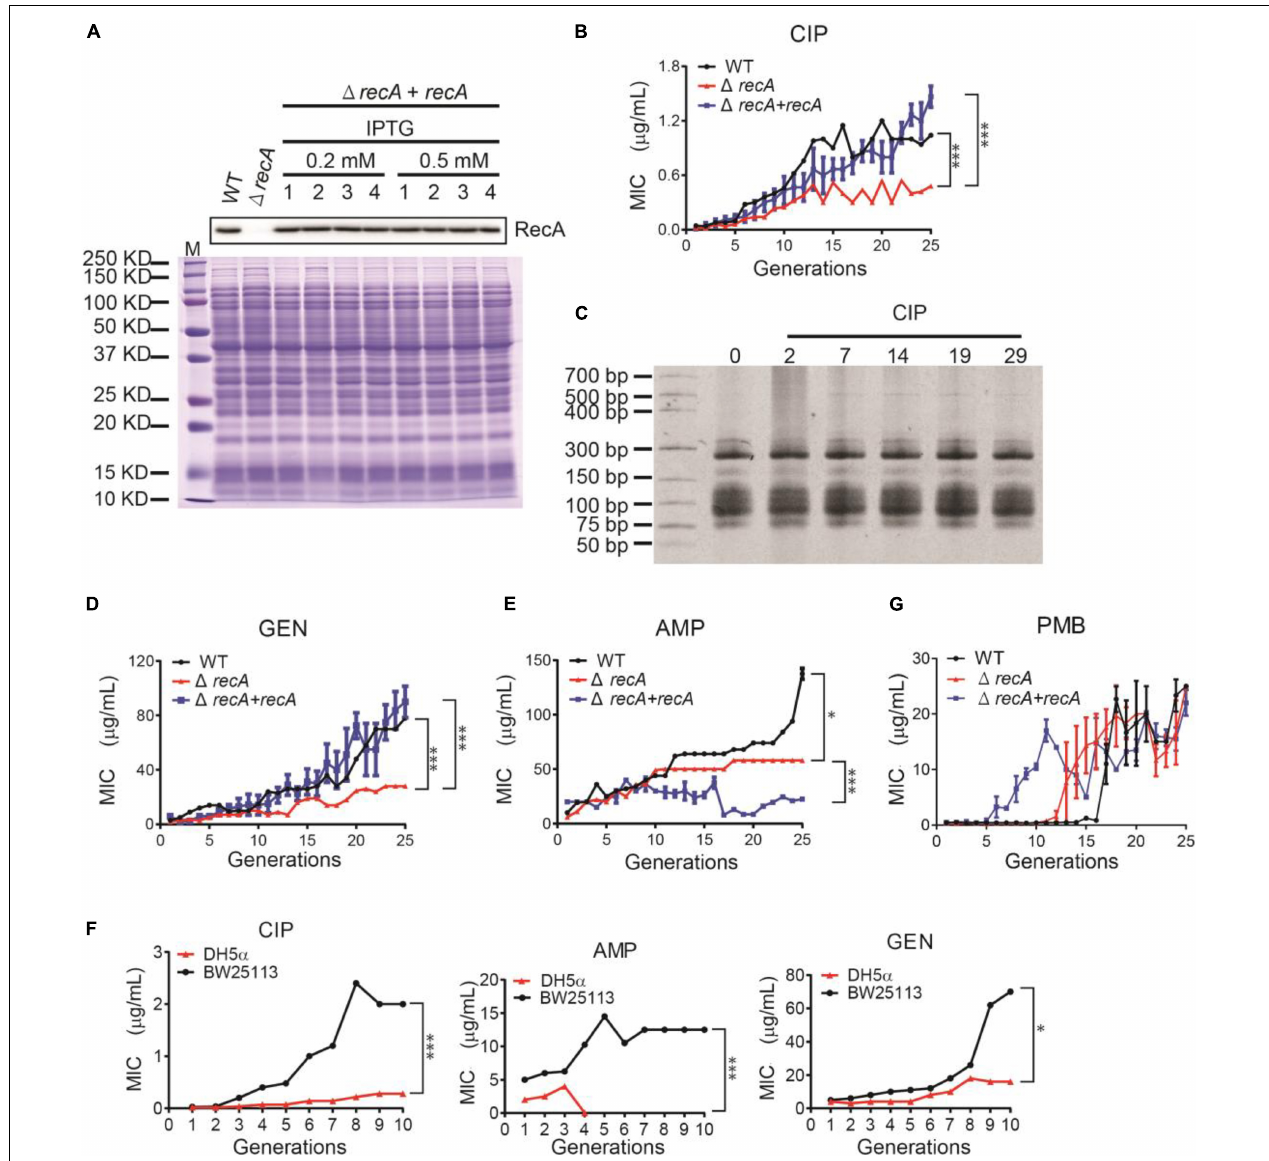
FIGURE 5 | Repressing the recombination abolish the AR evolution. (A) The deletion of the recA gene ( (cid:49) recA strain) and the RecA-restored strain ( (cid:49) recA + recA ). Western blot confirmed the RecA expression levels. The total protein gel stained with Coomassie blue was used as loading control for the same loading. 1 ∼ 4 represent the 4 independent biological replicates. (B) The MIC of the WT (black line), (cid:49) recA (red line), and RecA-restored (blue line) strains, respectively, during the subculturing with CIP. (C) The tRNA content during the subculturing with CIP, resolved in a PAGE. (D,E) The MIC of the three strains during the subculturing with gentamycin (GEN, D ) and ampicillin (AMP, E ), respectively. All MICs were illustrated as mean ± SD of three biological replicates. (F) The MIC of the WT (black line) and the DH5 α strain (red line) during the subculturing with CIP, AMP, and GEN, respectively. * P < 0.05. *** P < 0.0001. (G) Similar to (B,D,E) , the subculturing of the E. coli strains in polymyxin